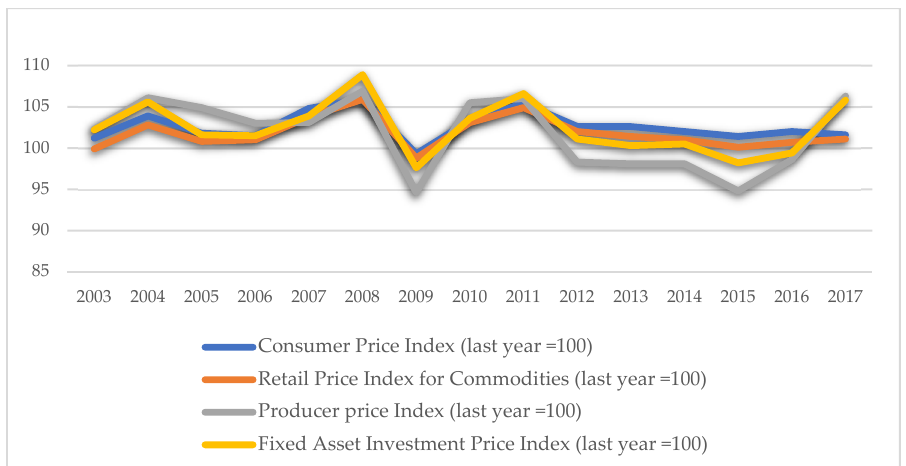
Figure 4. 2003–2017 price index (data source: China National Bureau of Statistics).